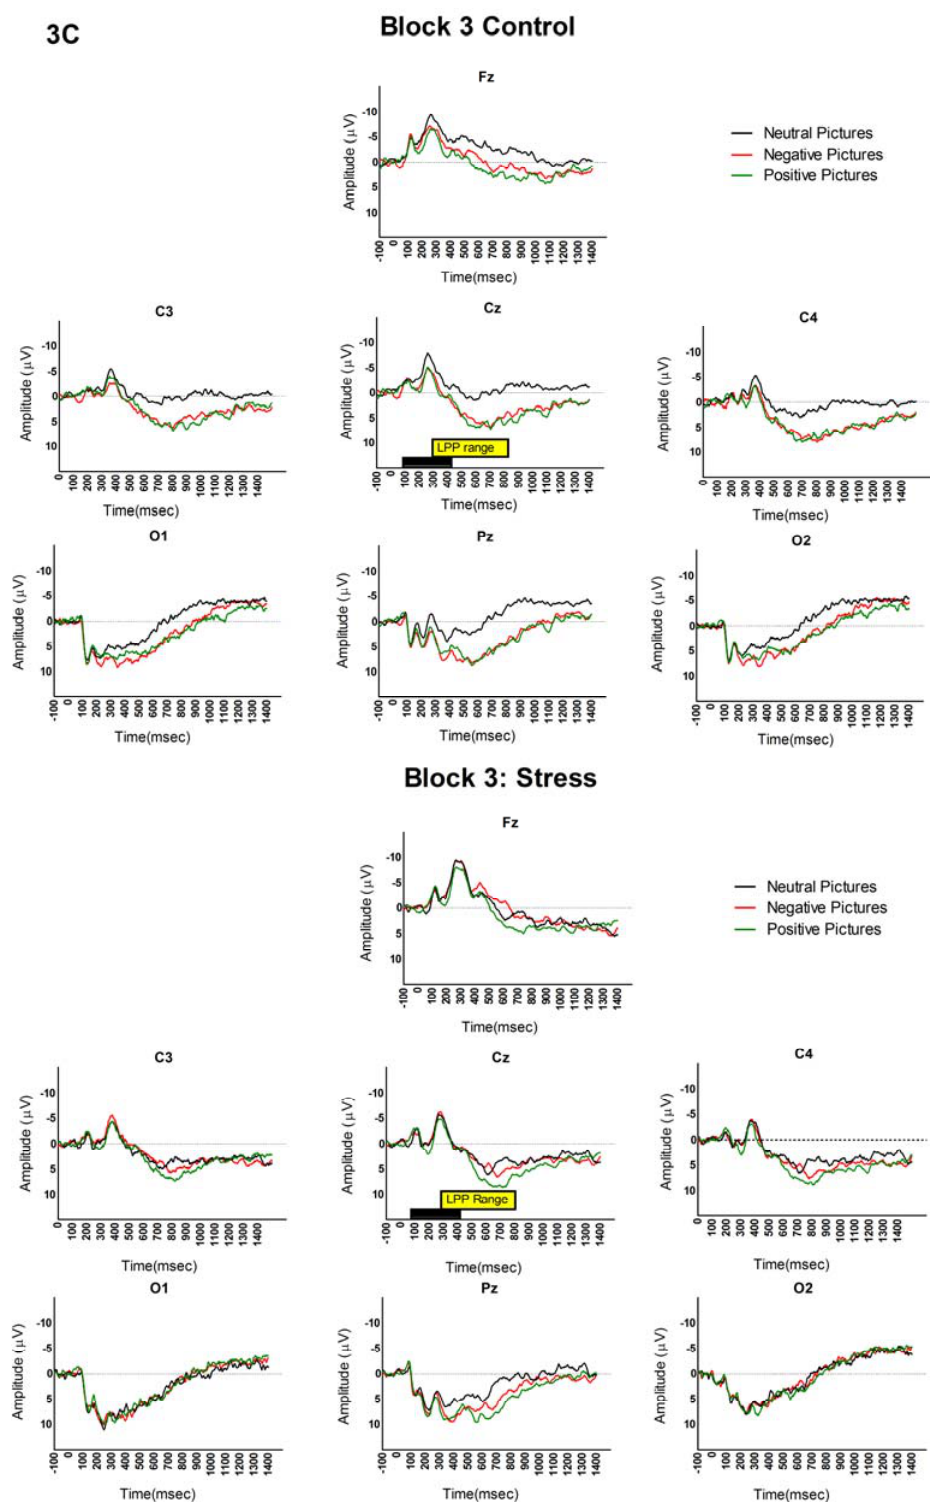
Figure 3. LPP ERP. The LPP ERP elicited by the IAPS in the control and stress conditions during each Block at each electrode location. In Blocks 1 and 2 ( 3A ) and ( 3B ), there were no differences in the LPP amplitude between the stress and the control conditions. However, in Block 3 ( 3C ), the neutral pictures elicited a larger LPP in the stress condition relative to the control condition during Block 3. Black horizontal bar in Cz indicates the 400 ms picture exposure and the yellow horizontal bar indicates the LPP analysis latency